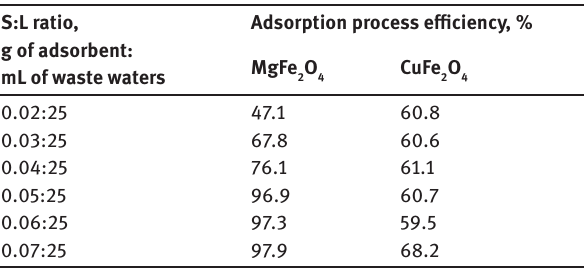
Table 1: The influence of the S:L ration upon the adsorption process efficiency.